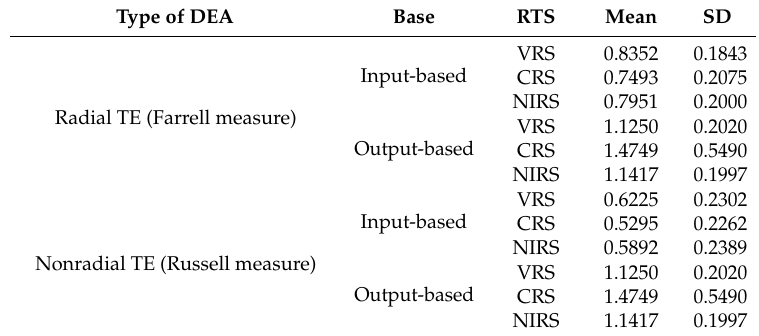
Table 3. Summary of both radial and nonradial TE under VRS, CRS, and NIRS